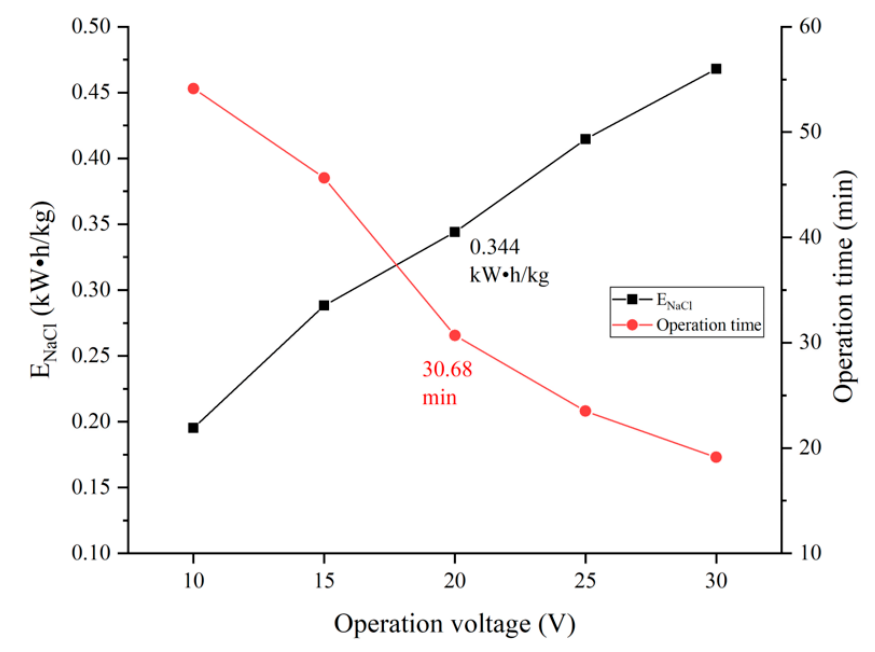
Figure 6. Influence of voltage on selection separation performance of the device.